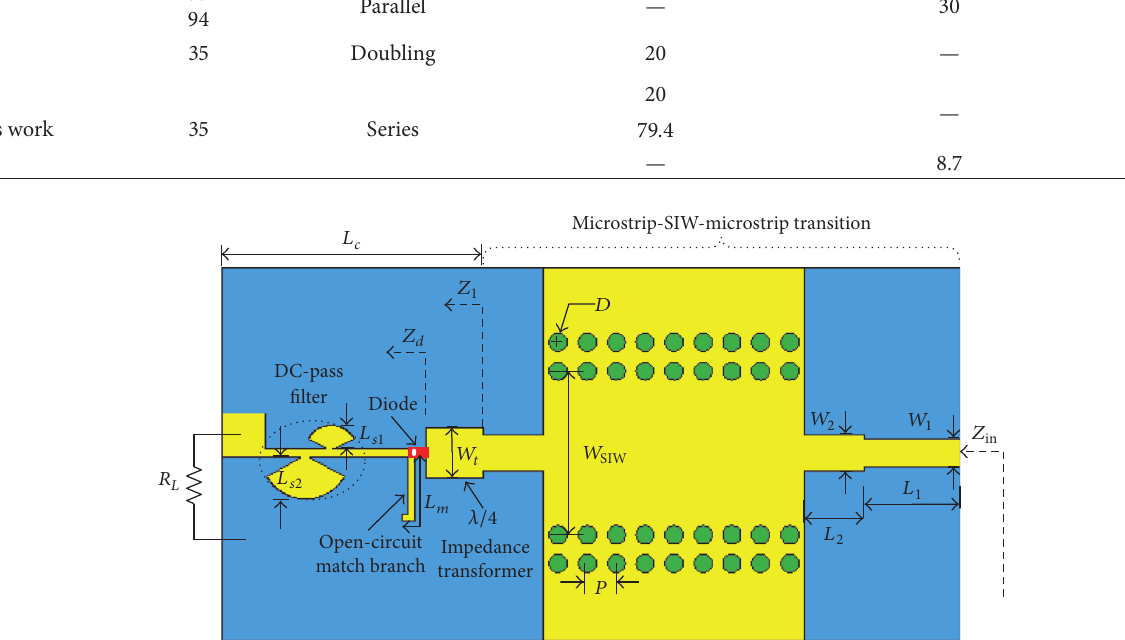
Figure 1: Structure of the rectifying